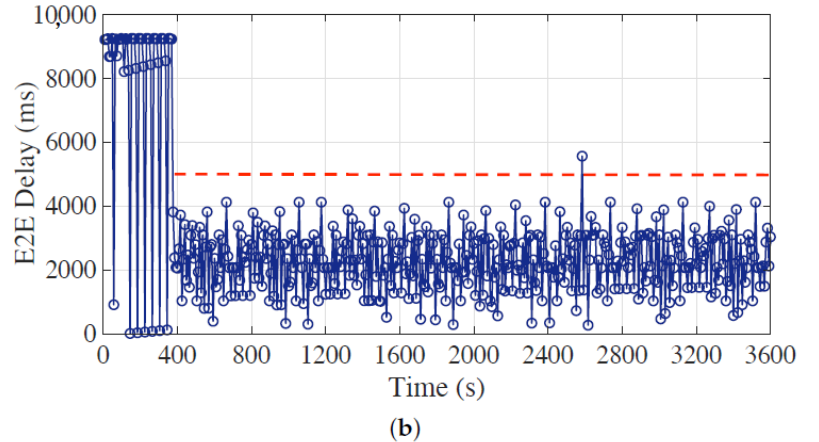
Figure 8. End-to-end (E2E) delay performance of the optimal bundling under static E2E delay requirement setting of ( a ) 8s and ( b ) 5s with the maximum bundling number of 10.